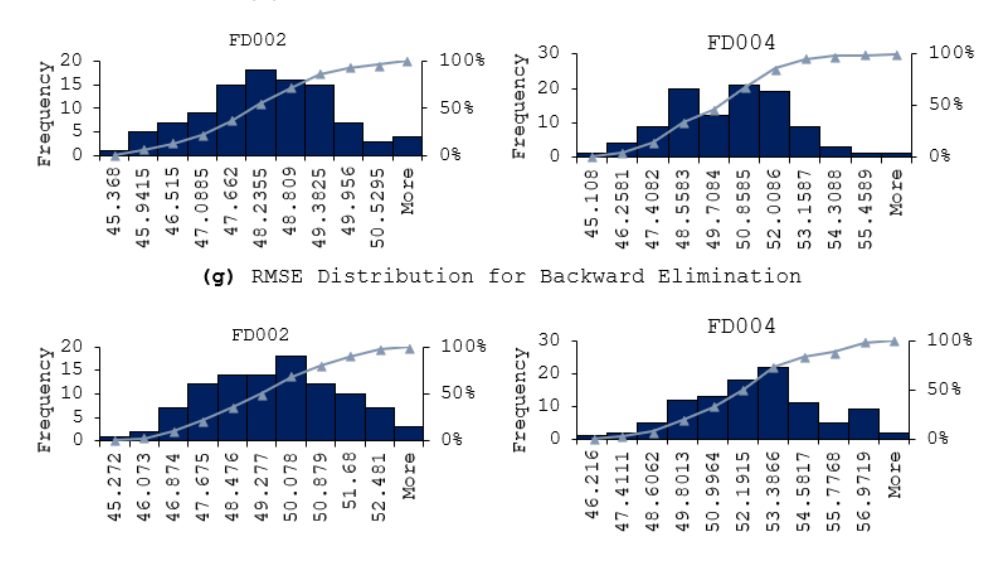
Figure 16. ( a – g ) Prediction Error Distributions. Table 6. Mean RMSE from all DNN models.